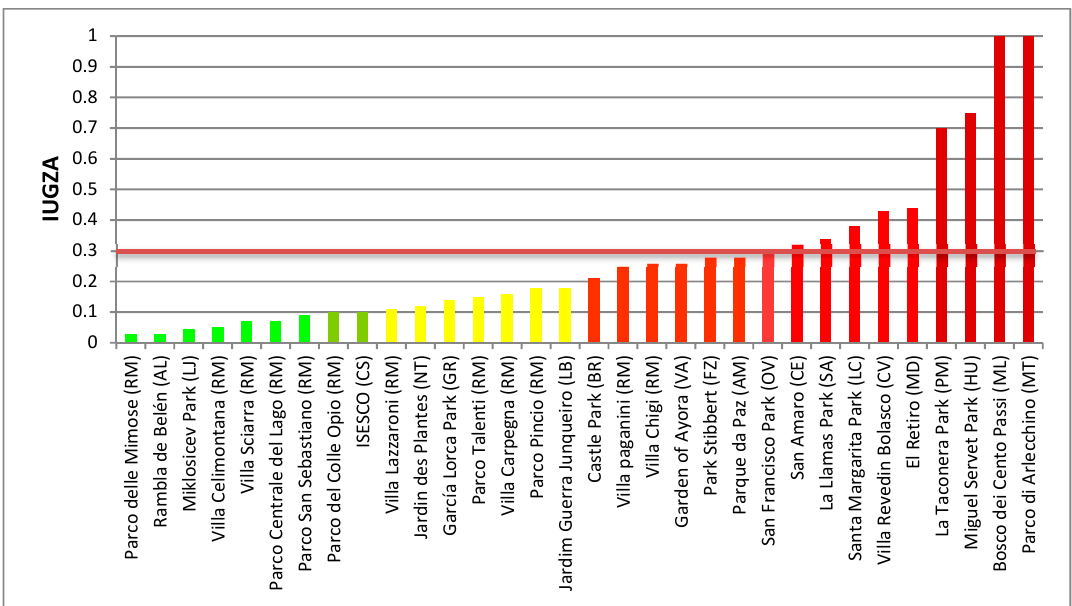
Figure 4. Index of Allergenicity of Urban Green Areas (I UGZA ) of the selected parks. RM: Rome; AL: Almeria; LI: Ljubljana: CS: Casablanca; NT: Nantes; GR: Granada; LB: Lisbon; BR: Bragança; VA: Valencia; FZ: Florence; AM: Almada; OV: Oviedo; CE: Ceuta; SA: Santander; LC: La Coruña; MD: Madrid; PM: Pamplona; HU: Huesca; ML: Milan; MT: Mantua.